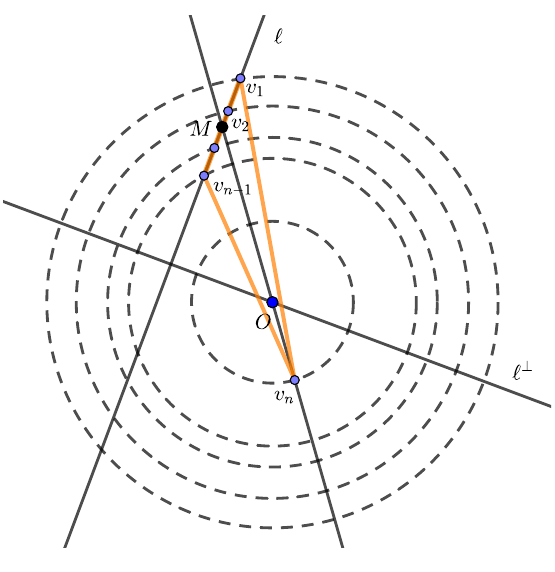
Figure 2. The construction of a convex polygon with respect to the given distinct constrained vertex